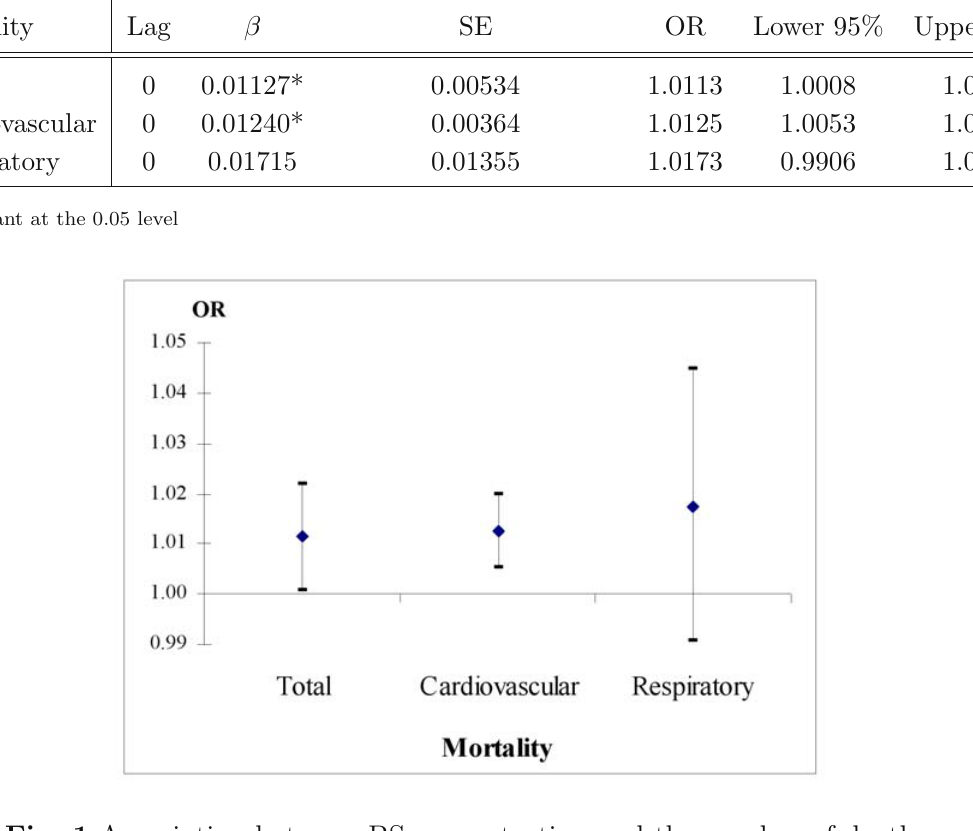
Fig. 1 Association between BS concentration and the number of